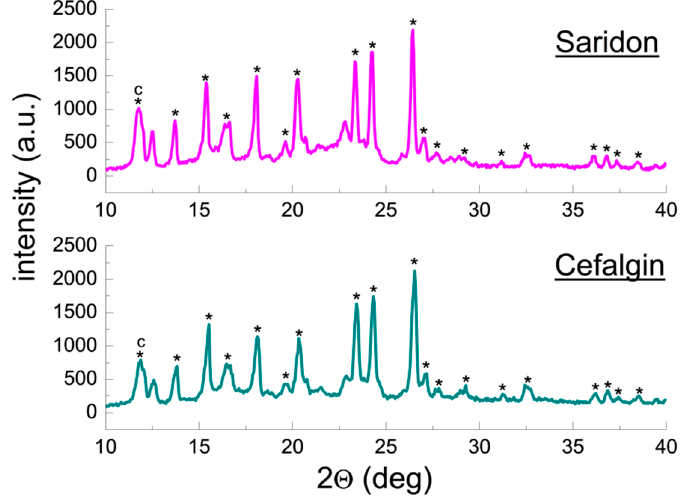
Figure 6. Diffraction patterns for drugs: Saridon and Cefalgin. (* - acetaminophen, c – caffeine)